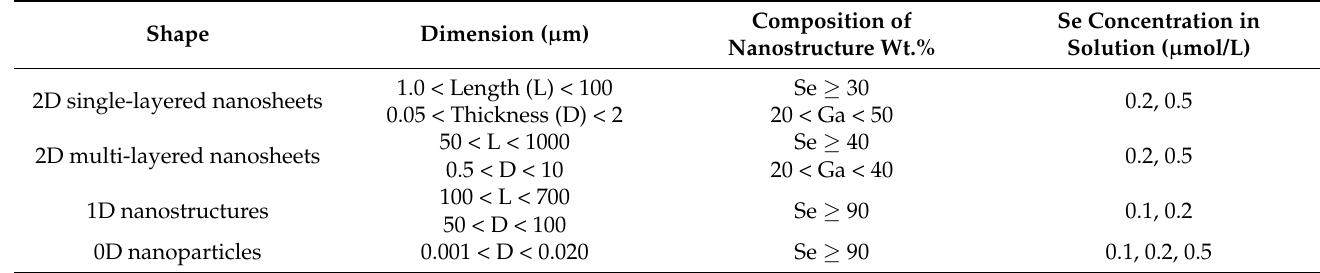
Table 1. The specifications of various types of synthesized Se-rich